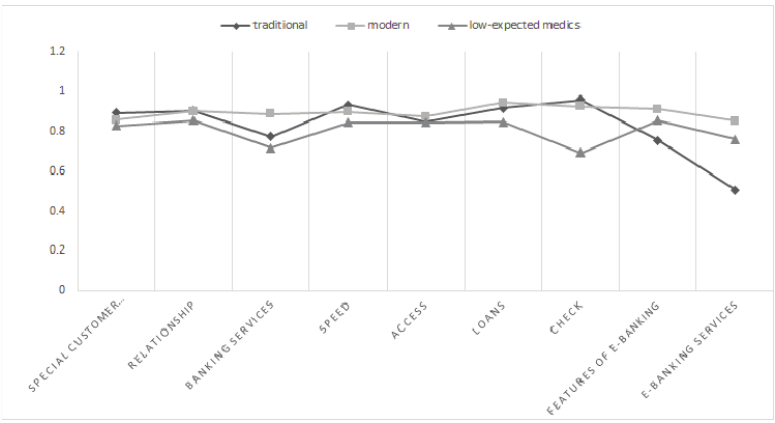
Fig. 1 - Average banking expectations among the three clusters identified (Source: Authors) According to table 1, it is clear that importance of the following factors in all 3 clusters are nearly the same: interaction with special customers, relationship, accessibility, speed and loans; this is while factors like variety and features of e-banking services, check and bank services had significant difference among the